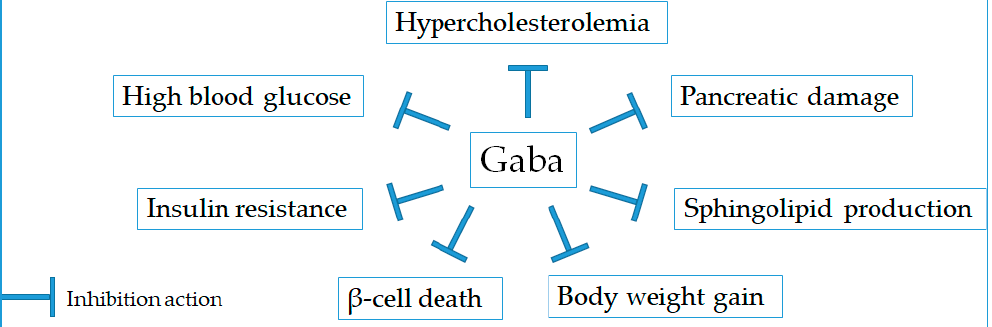
Figure 3. Therapeutic targets for anti-diabetic activity of Gaba. Table 4. Anti-diabetic effect of Gaba.